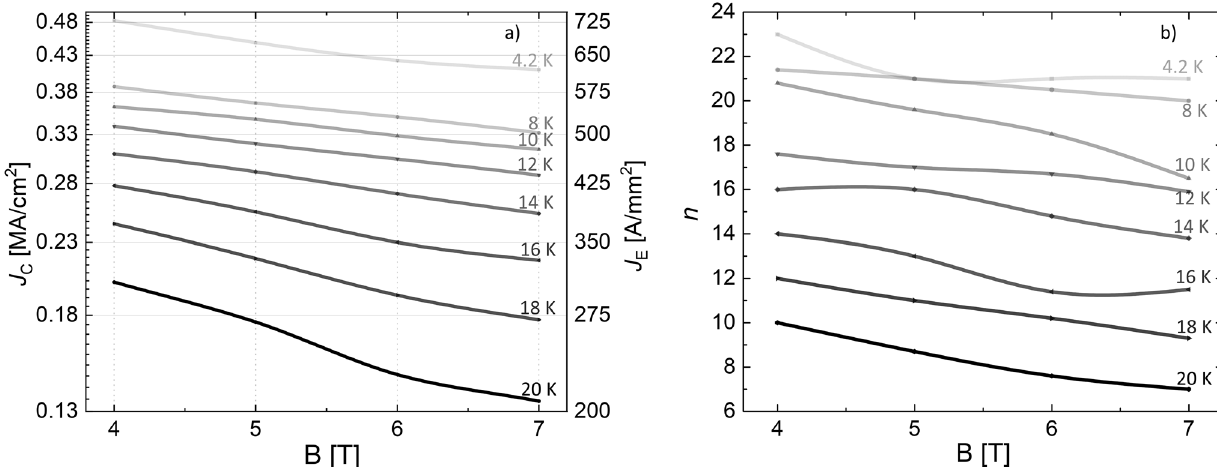
n ) as a function of the applied magnetic field